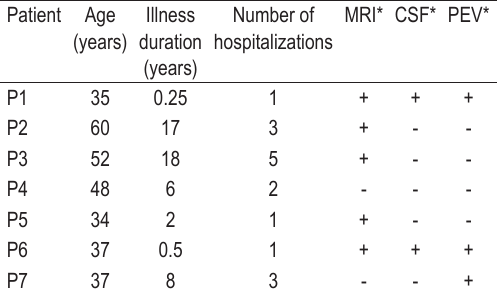
TABLE 1. Patient characteristics and the core diagnostic findings